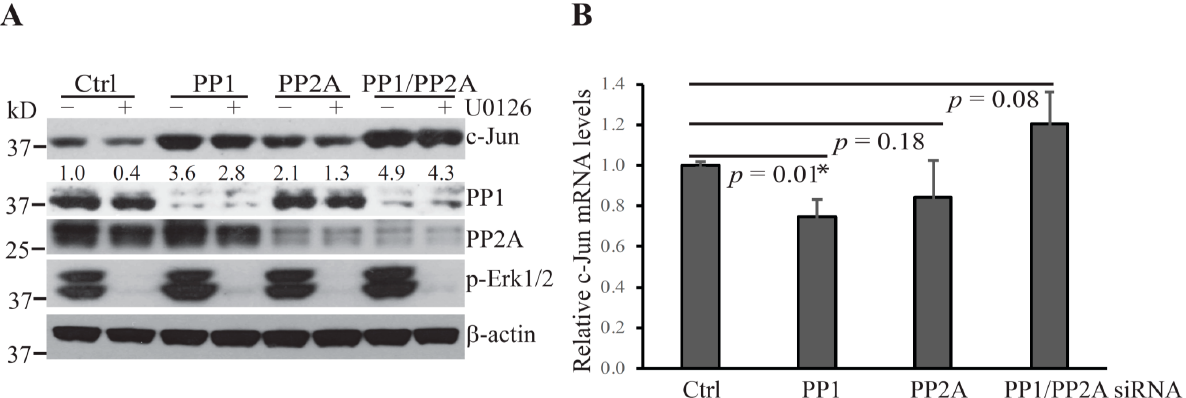
Figure 2. Protein phosphatases PP1 and PP2A promote c-Jun degradation following U0126 treatment. ( A ) Hepa1c1c7 cells were transfected with the indicated siRNA targeting PP1 and/or PP2A. Two days following transfection, the cells were cultured with or without U0126 for 1 h and then extracted with NuPAGE LDS sample buffer. The expression levels of the indicated proteins in the cell lysates were assessed by Western blotting. Knockdowns of target proteins by siRNAs were confirmed at the protein level by Western blotting. Band intensities of c-Jun were quantified and normalized using β -actin levels. The normalized protein levels are shown under each band. Data shown are representative of three independent experiments. ( B ) Two days following transfection of PP1 and/or PP2A siRNA, Hepa1c1c7 cells were extracted with TRIzol for RNA preparation. c-Jun mRNA levels were measured by qPCR and normalized by the levels of Gapdh . Data shown were generated from two sets of independently prepared samples assessed by qPCR twice. Data were statistically analyzed using an unpaired, two-tailed Student’s t -test and significant difference * was determined by p <